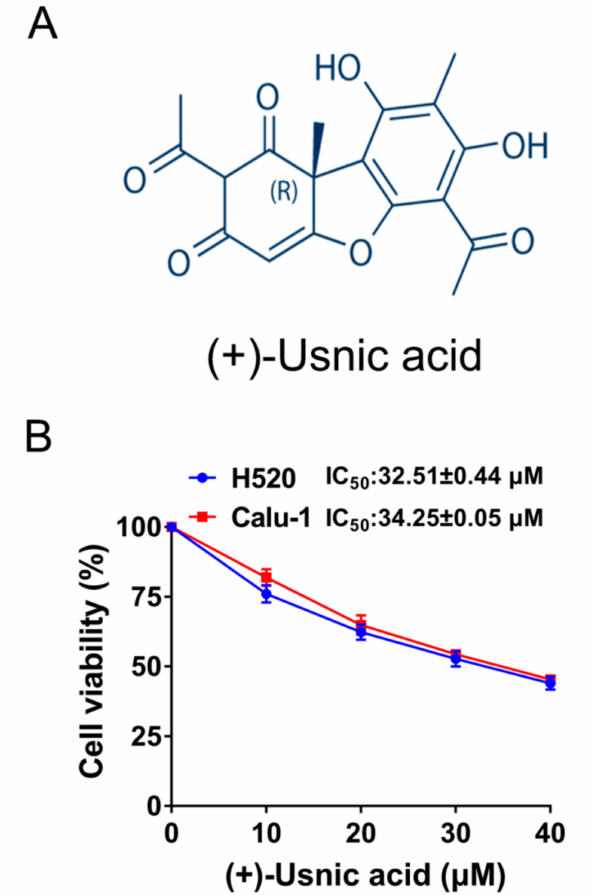
Figure 1. ( + )-Usnic acid (UA) inhibits viability and induces apoptosis in lung squamous cell carcinoma (LUSC) cells. ( A ) The structure of ( + )-usnic acid. ( B ) The e ff ect of UA on the viability of H520 and Calu-1 cells, determined by MTT assay at the indicated concentrations after 48-hour